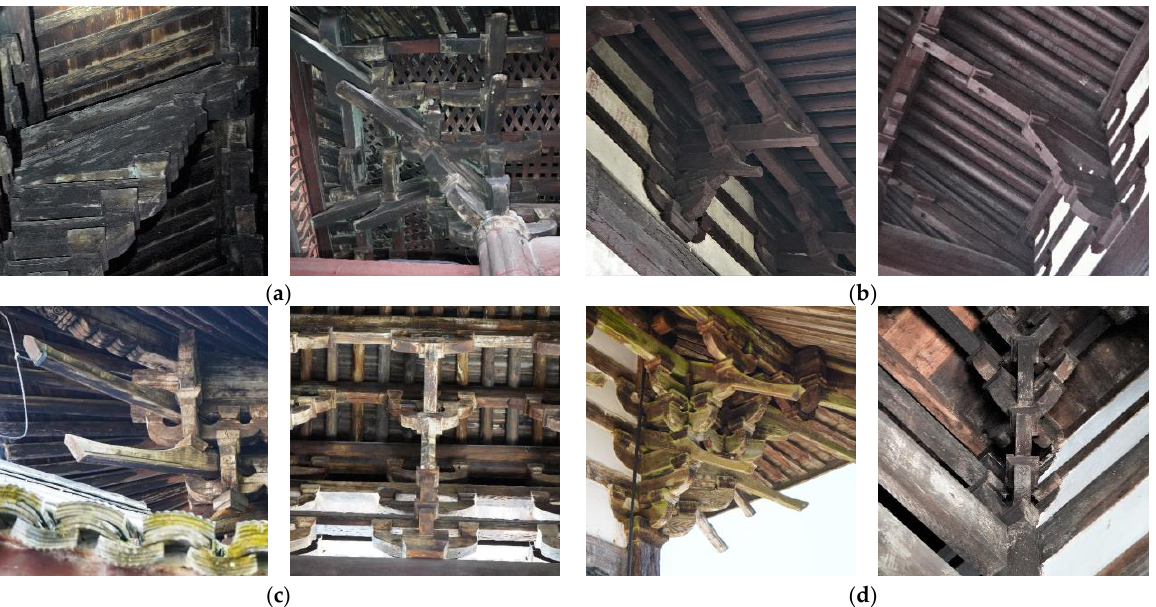
Figure 3. On-site investigations of the typical Dou-gongs of early Chinese traditional timber buildings: ( a ) Dou-gongs in the main hall of Bao-guo Temple (AD 1013); ( b ) Dou-gongs in the main hall of Tian-ning Temple (AD 1318); ( c ) Dou-gongs in the main hall of Yan-fu Temple (AD 1317); ( d ) Dou-gongs in the main hall of Shi-si Temple (AD 1356).